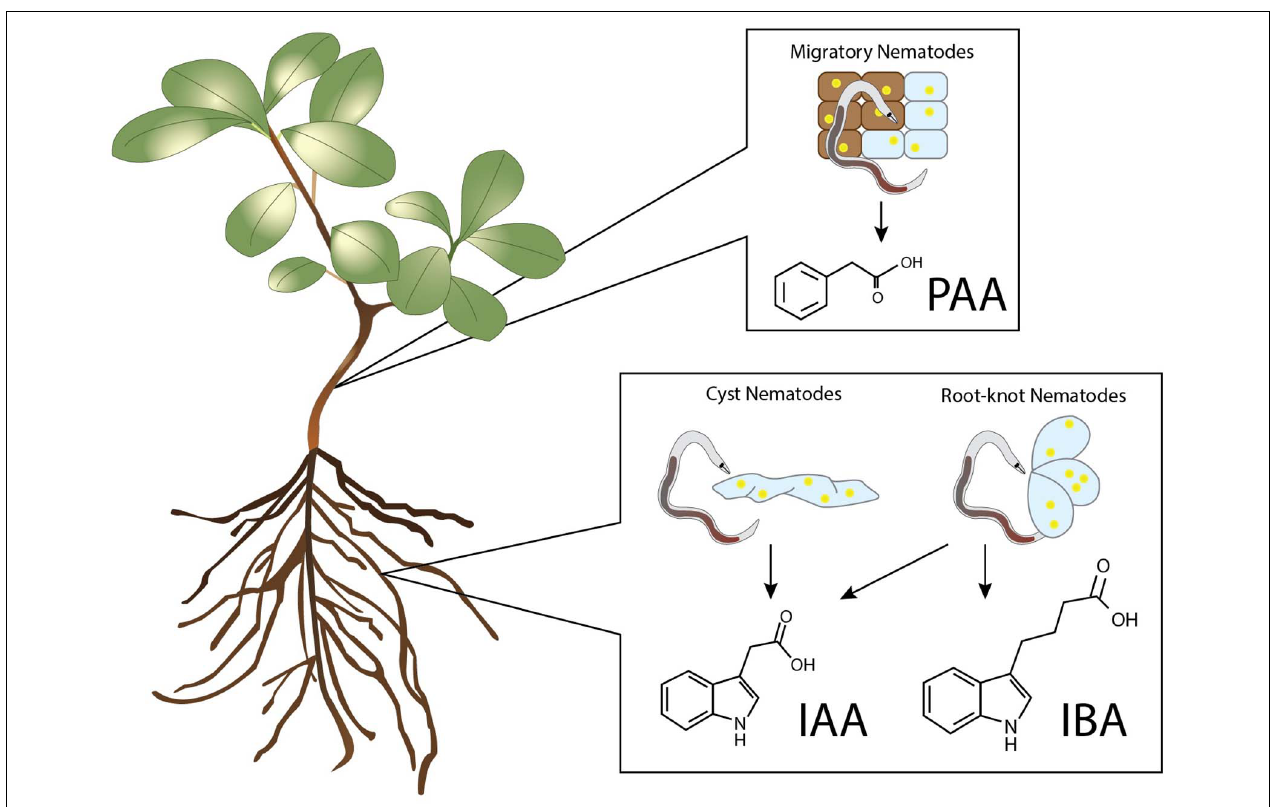
FIGURE 1 | Auxins detected in nematode infected plant tissues. PAA was detected in callus upon infection by the necrotrophic plant-parasitic nematode Bursaphelenchus xylophilus (Kawazu et al., 1996; Zhang et al., 1997). Increased levels of IAA have been found in the infection sites of the cyst nematodes Heterodera schachtii , H. cruciferae , H. trifolii , and Globodera rostochiensis , and in the galls of the root-knot nematodes Meloidogyne incognita , M. hapla , and M. javanica (Yu and Viglierchio, 1964; Viglierchio and Yu, 1968; Hanschke et al., 1975; Agarwal et al., 1985; Ganguly and Dasgupta, 1987). Elevated levels of IBA were only found in the infection sites of the root-knot nematode M. incognita (Yu and Viglierchio, 1964).